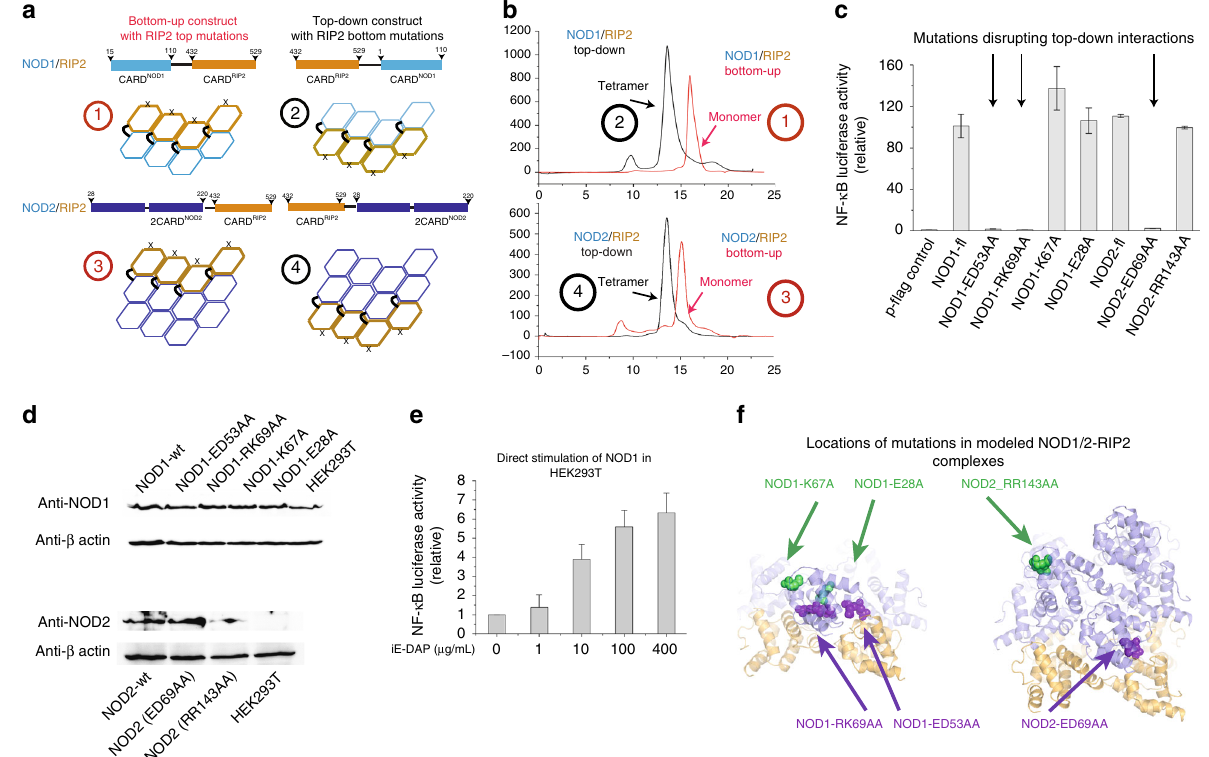
Fig. 7 Both NOD1 and 2 activate RIP2 in a top-down interaction mode. a The design of NOD1/RIP2 and NOD2/RIP2 fusion constructs. According to our structural model, we introduced mutations located on RIP2 – CARD surfaces to prevent aggregation. b Size-exclusion chromatographic pro fi les of bottom-up and top-down constructs of NOD1/RIP2 and NOD2/RIP2 fusions. Both top-down constructs (constructs 1 and 3 in Fig. 6a) appeared to form stable tetramers in solution, not the other way around. Since RIP2 – CARD tends to self-oligomerize, N449A – K513E mutant of RIP2 – CARD domain was used to prevent self-interactions in bottom-up constructs, and R444E – E445R mutant of RIP2 – CARD domain was used in top-down constructs. Without incorporating the RIP2 – CARD mutations, fusion constructs precipitate. c NF- κ B promoter activation by NOD1, NOD2, NOD1 mutants, and NOD2 mutants in HEK293T cells. HEK293T cells were transfected with empty vector, wild-type NOD1, wild-type NOD2, NOD1 mutants, and NOD2 mutants together with pGL4.32 NF- κ B-RE vector and CMV- Renilla vectors. Cells were harvested 24 h post transfection and the level of NF- κ B promoter activity was measured by dual luciferase assay according to the manufacturer ’ s instructions. d Expression levels of NOD1, NOD2 constructs, and their mutants were similar. HEK293T cells were transfected with wild-type NOD1/2 as well as their mutants. Endogenous levels of NOD1 and NOD2 in HEK293T cells were also monitored. Western blots were representative of three independent experiments. e NF- κ B promoter activation after iE-DAP stimulation in HEK293T cells. Error bar represents standard deviation values of three independent repeats. f Illustrations highlighting the locations of the NOD1/NOD2 mutations tested in ( a ). Green arrows highlighted mutations on the top surfaces of NOD1/2 CARD domains, while purple arrows highlighted the bottom mutations. Only bottom surfaces from NOD1/2 CARD domains were functionally important. RIP2 utilizes the same interface to interact with both NOD1 and